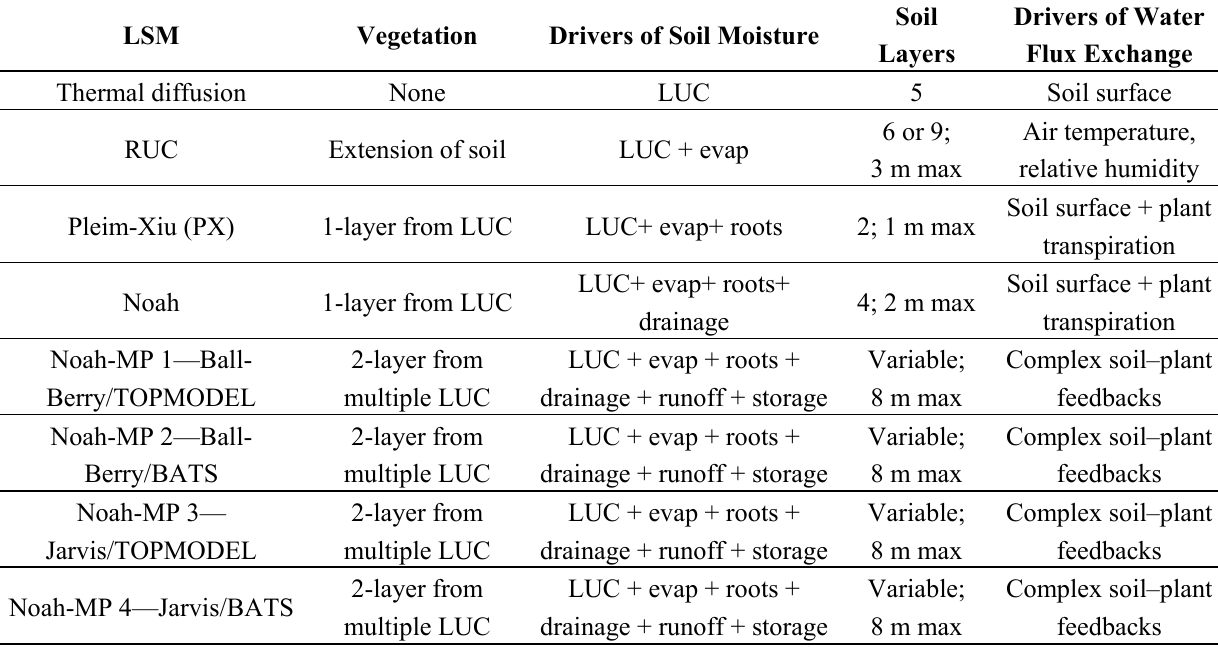
Table 2. Configuration of the WRF land surface model (LSM) ensemble. Also listed are the surface runoff and stomatal conductance parameterizations used in Noah-MP. LUC = land use